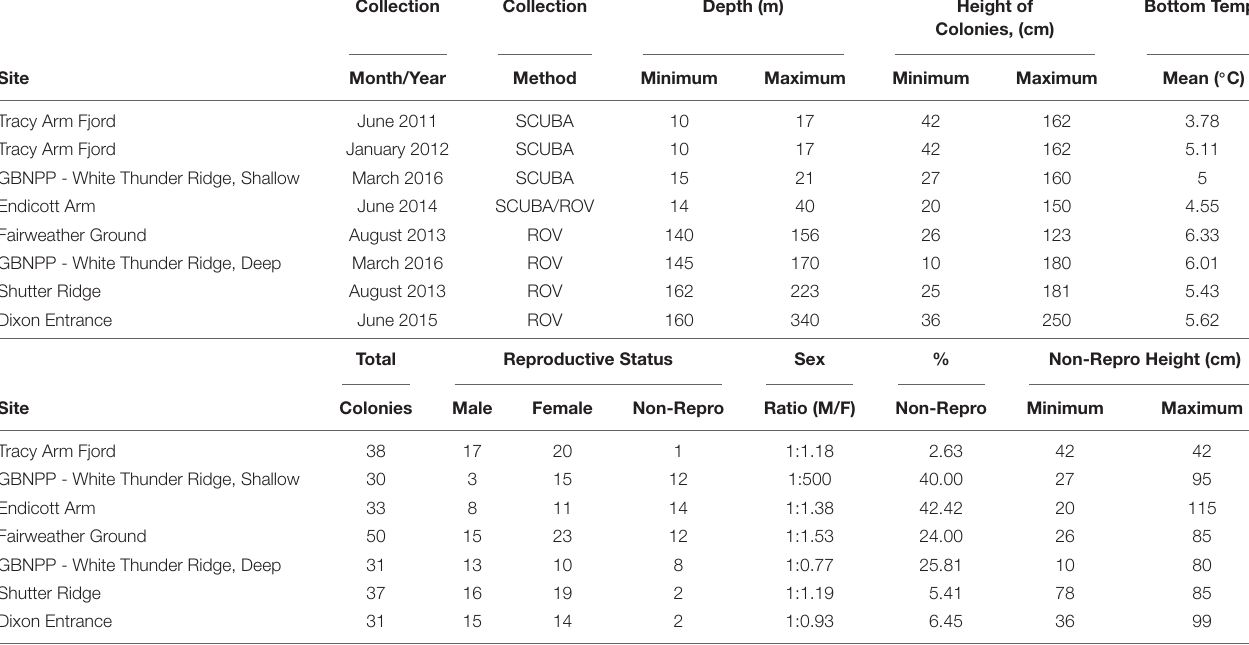
TABLE 1 | Sample collection details for each site ordered by shallowest to deepest